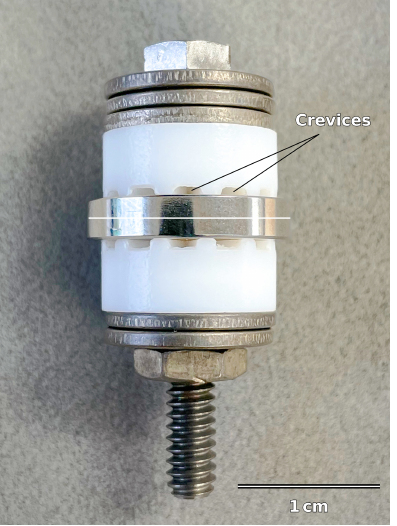
Figure 1. Multiple crevice assembly with Alloy 22